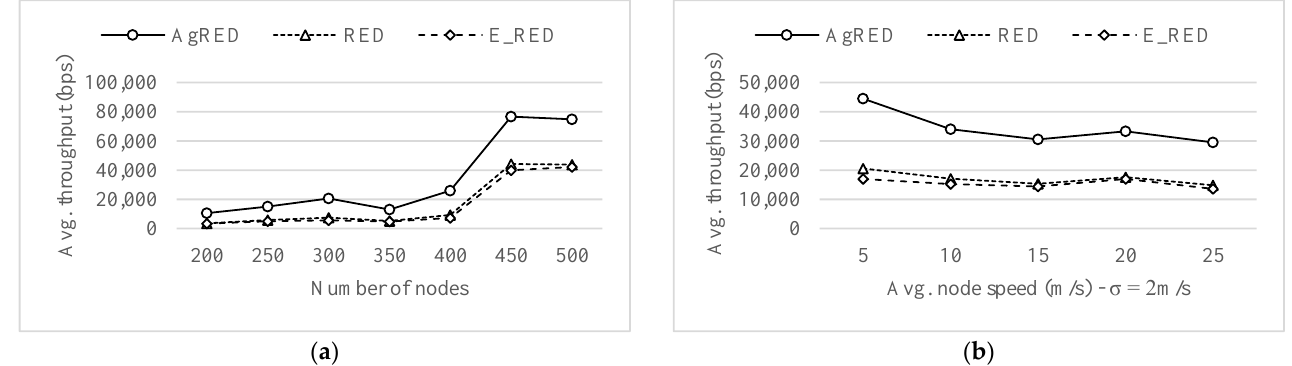
Figure 13. Average throughput (UDP) vs. ( a ) number of nodes and ( b ) average node speed. The gain insured in throughput going from 400 nodes to 450 nodes is 33.8% in AgRED, while RED gain in throughput is 20.9% and E_RED has the least gain of only 18.2% as compared to other two techniques. This improvement in gain also favors the AgRED implementation, which offers at least 12.8% and 15.5% more performance as compared to RED and E_RED, respectively. Though the improvement in throughput is evident in Figure 13a, Figure 13b shows the throughput trend against the average speed of the nodes. Apart from the improvements of AgRED, it is important to note here that all three techniques suffer from lower throughput as average speed is increased. Though, AgRED here as well performs such that the lowest throughput at 25 m/s (29,544.44 bps) is still higher than the highest throughput of RED at the speed of 5 m/s (20,548.57 bps). Similar to end-to-end delay, throughput is measured for each receiving packet and therefore is a random variable. Figure 14 represents the box plot for the throughput of all three techniques, highlighting major improvements for AgRED against RED and E_RED. It can be seen that the highest throughput achieved is by AgRED for the 450 nodes, with a peak throughput of more than 120,000 bps.